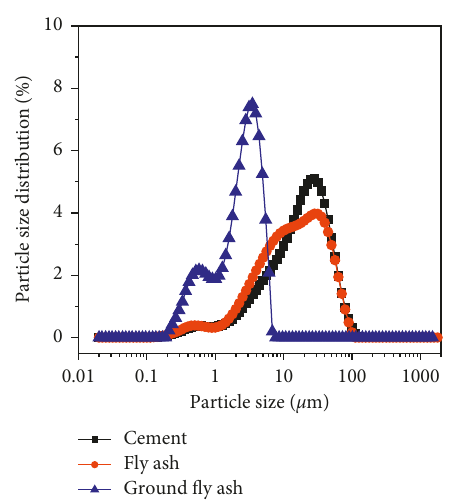
Figure 3: Particle size distribution of raw